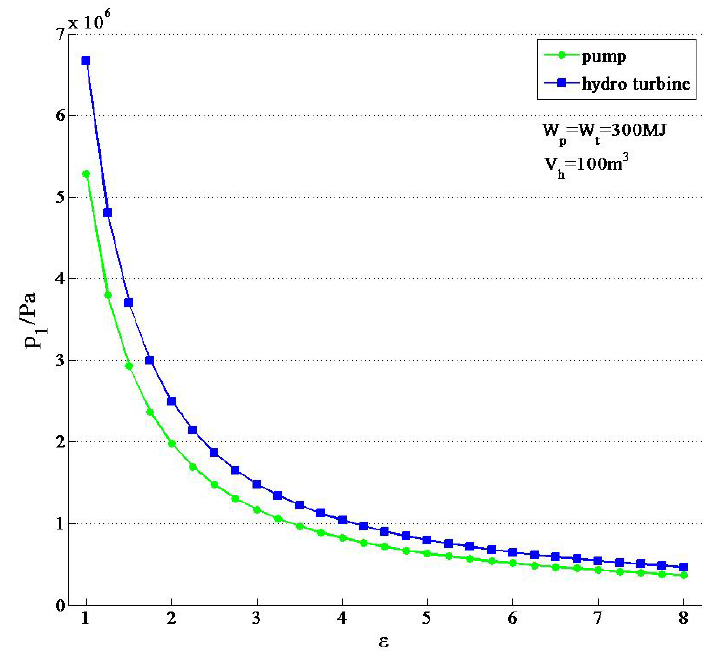
Figure 9. Vessel volume various with water-air volume